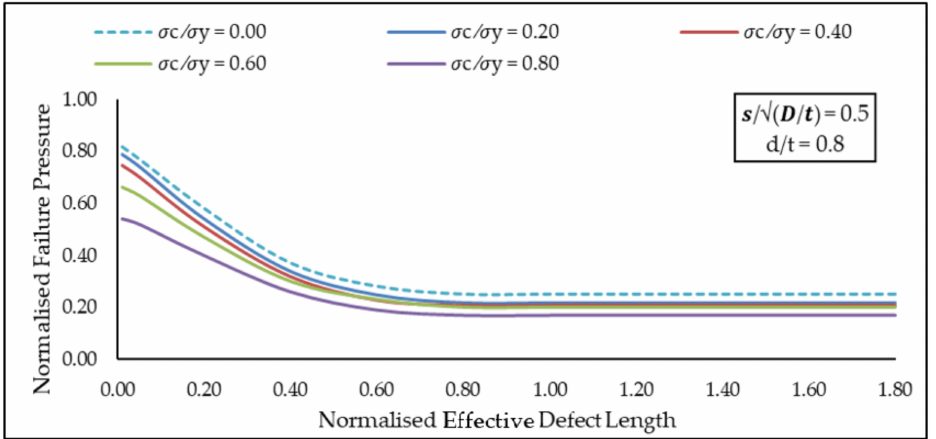
Figure 18. Normalized failure pressure predictions based on the empirical equation against various normalized defect lengths for multiple axial compressive stresses at constant normalized defect depth of